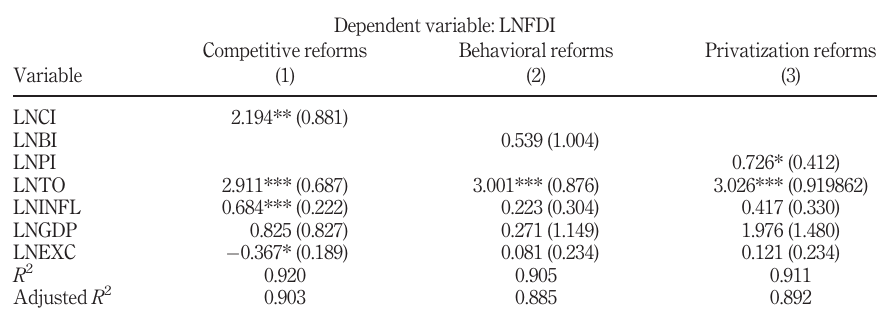
Table 4. FMOLS Results